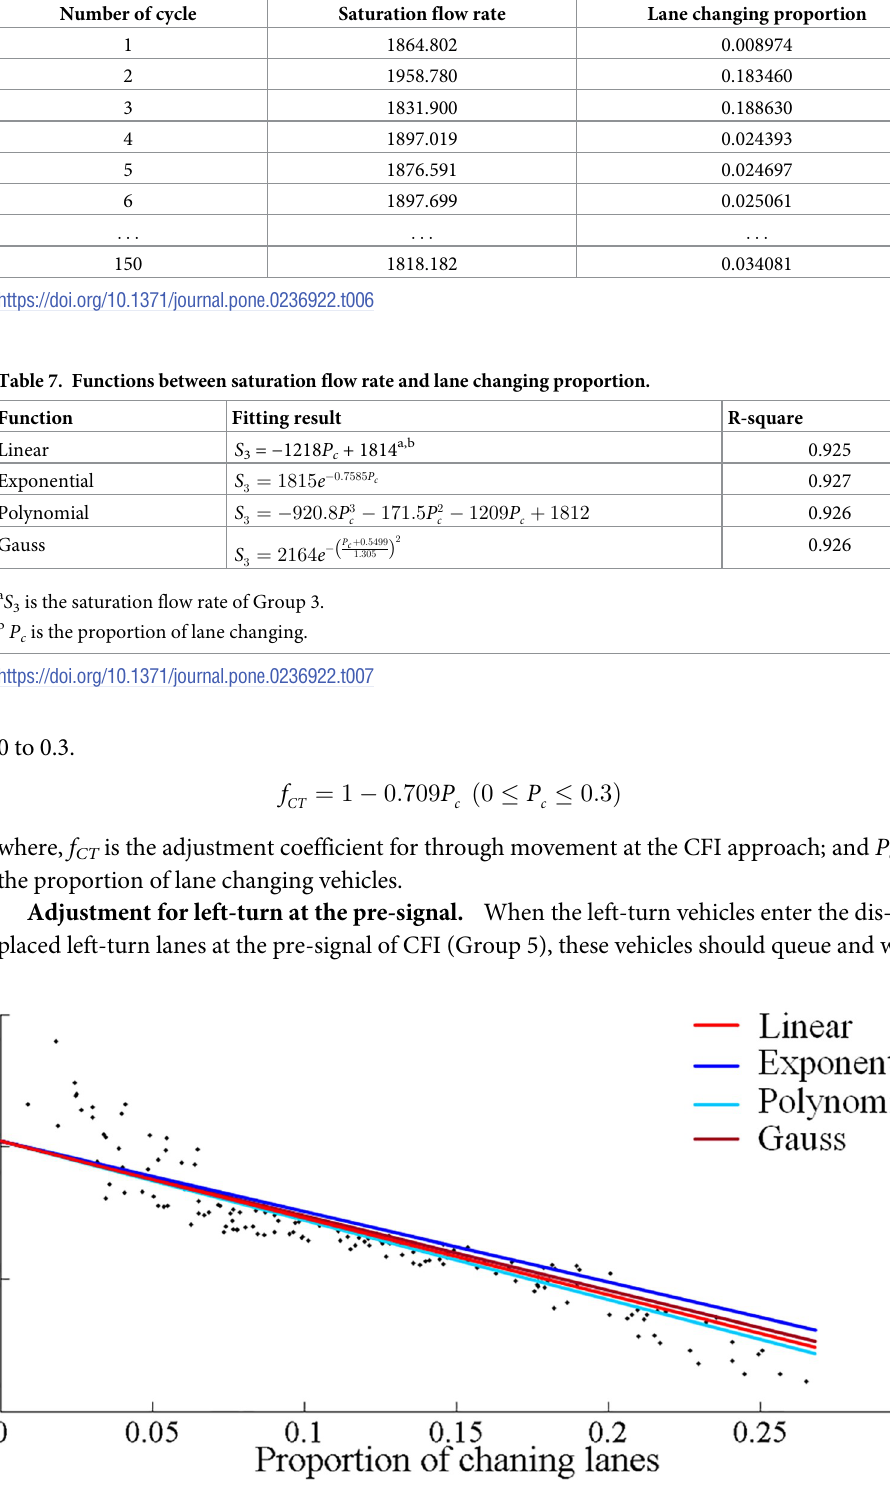
Fig 6. Fitting curves of saturation flow rate at CFI and lane changing